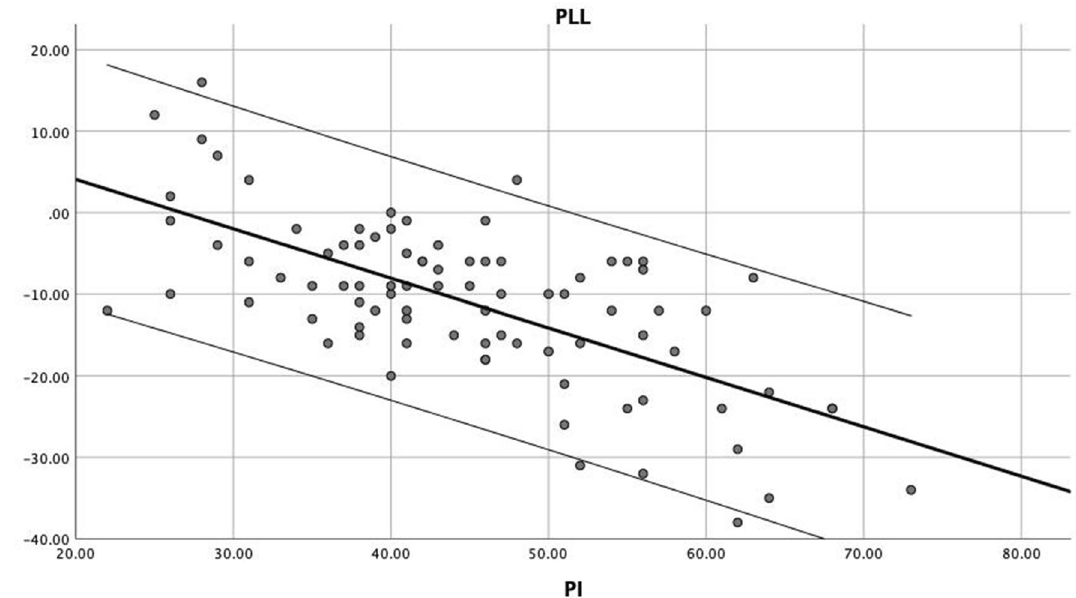
Figure 4. Linear stepwise regression between proximal lumbar lordosis and pelvic incidence (R 2 = 0.452, PLL = 16.2–0.61 * PI, p < 0.001). PLL, proximal lumbar lordosis; PI, pelvic incidence.